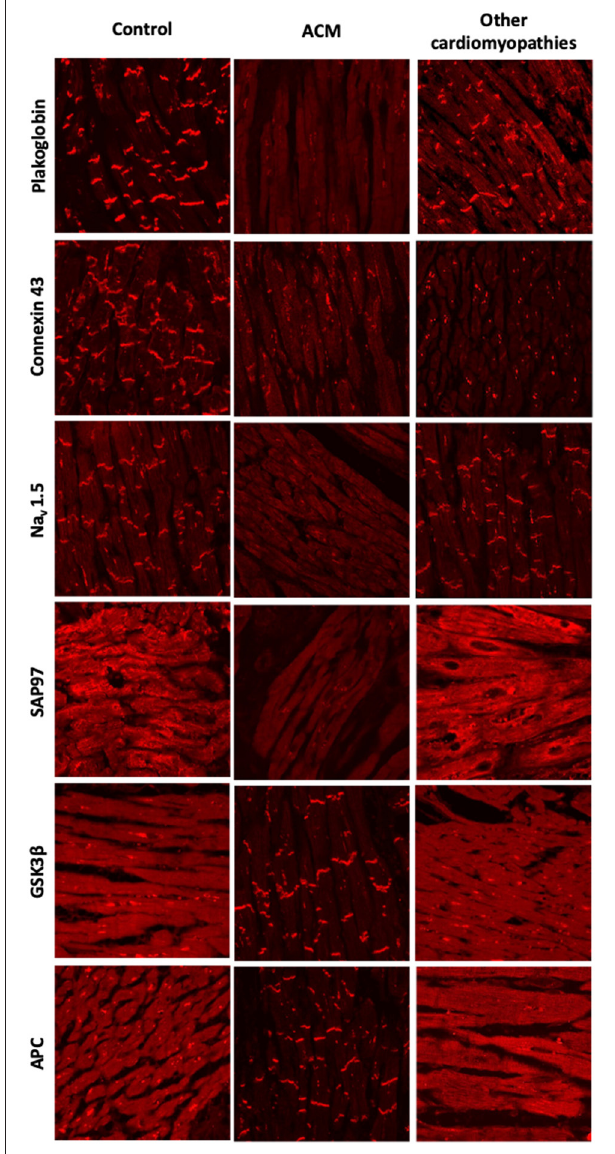
FIGURE 2 | Protein re-distribution in the hearts of ACM patients. Representative confocal immunofluorescence images showing loss of junctional signal for PG, Cx43, and Nav1.5 in ACM myocardium compared to controls. Additionally, both sarcomeric and junctional signal for SAP97 is lost while GSK3 β and APC translocate to the junctions. Myocardium from patients with other forms of cardiomyopathy show normal distribution of PG, Nav1.5, GSK3 β and APC. Gap junction remodeling is, however, evident and ID signal for SAP97 is also lost, though its sarcomeric distribution is